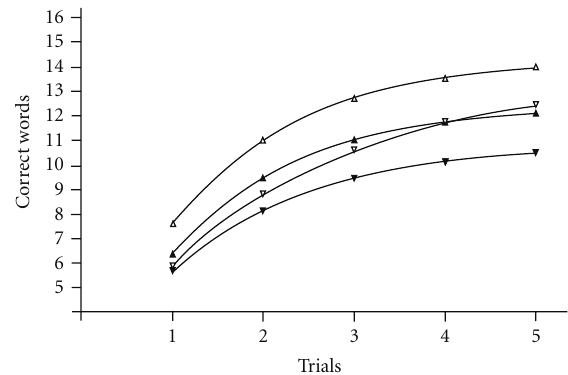
Figure 3: The averaged learning curves over all healthy participants and MS patients. Empty triangles—Healthy female participants; B 2 = 0.70; B 3 = 7.63; B 4 = 14.38. Filled triangles—MS female patients; B 2 = 0.72; B 3 = 6.35; B 4 = 12.44. Empty down triangles—Healthy male participants; B 2 = 0.47; B 3 = 5.90; B 4 = 13.58. Filled down triangles—MS male patients; B 2 = 0.64; B 3 = 5.66; B 4 = 10.86. B 3 is higher in healthy females versus healthy males ( P = . 0016). B 3 ( P = . 0019) and B 4 ( P = . 0018) is higher in healthy female participants versus MS female patients. B 4 is higher in healthy male participants versus MS male participants ( P = . 006). B 3 ( P = . 006) and B 4 ( P = . 002) is higher in MS female patients in comparison with MS male